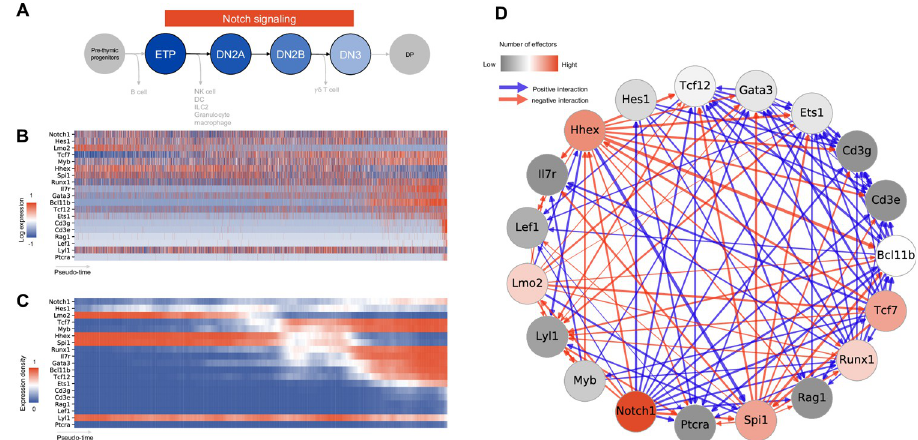
Fig 2. IQCELL initial processing of early T-cell development sc-RNA seq data. (A) Summary of the scope of the sc- RNA seq data used as an input to IQCELL [18]. ETPs originated from pre-thymic progenitors progress toward DN2A, DN2B (coincides with upregulation of Bcl11b and lineage commitment), DN3 stages and eventually lead to DP cells (not covered here). (B) Log transformed expression matrix for selected genes from sc-RNA data along the pseudo-time axis. Gene expression is corrected for dropout effects using MAGIC [24]. Red indicates high expression, blue indicates low expression. (C) Smoothed binarized gene expression matrix (expression density). Gene expression values were binarized by clustering, averaged over a pseudo-time window, then sorted based on transition points from early to late. Red indicates high expression, blue indicates low expression. (D) The set of all possible gene-gene interactions, filtered by interaction hierarchy and mutual information. Positive and negative interactions are represented by blue and red edges, respectively. Edge width represents the relative amount of mutual information of the interaction.